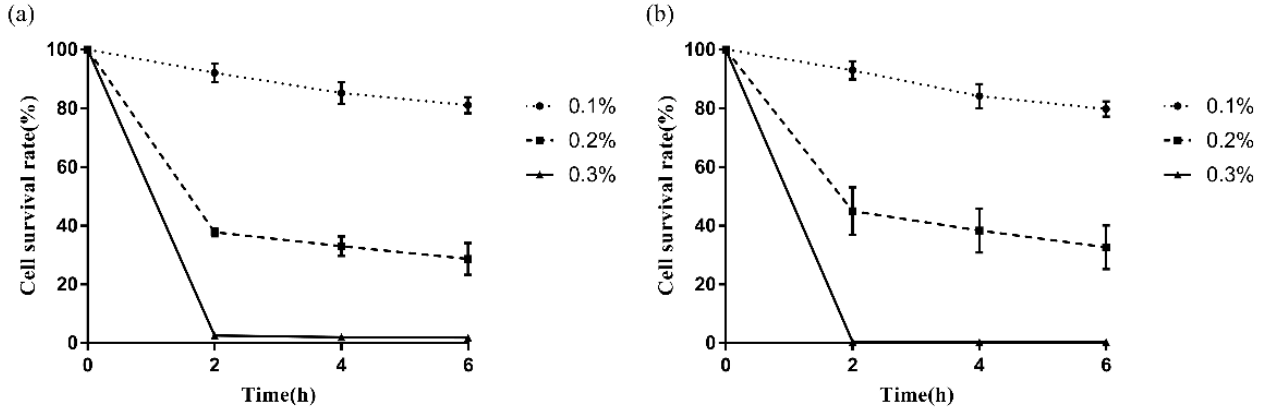
Figure 6. The survival rates of P. pentosaceus 2-5 ( a ) and L. reuteri L-3 ( b ) in the presence of bile salts after 2 h, 4 h, and 6 h of incubation with different concentrations (% w / v ). The results represent the mean ± SD of three independent experiments.